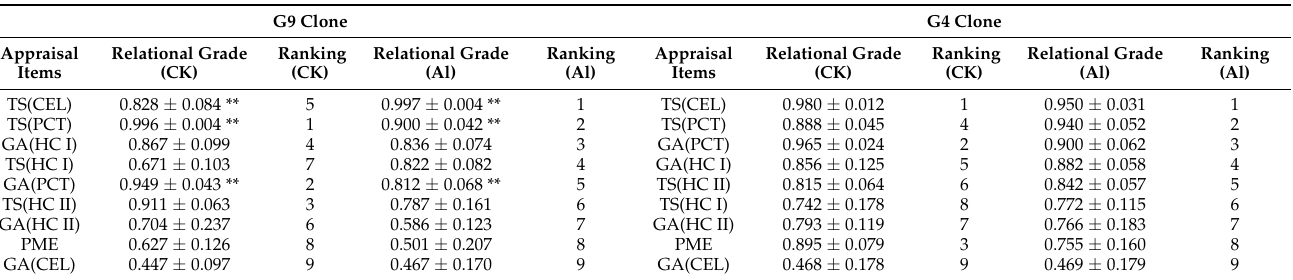
Table 1. Gray correlation degree (mean ± SD) and ranking of TS, GA content, and PME activity with Al 3+ concentration in root tip cell